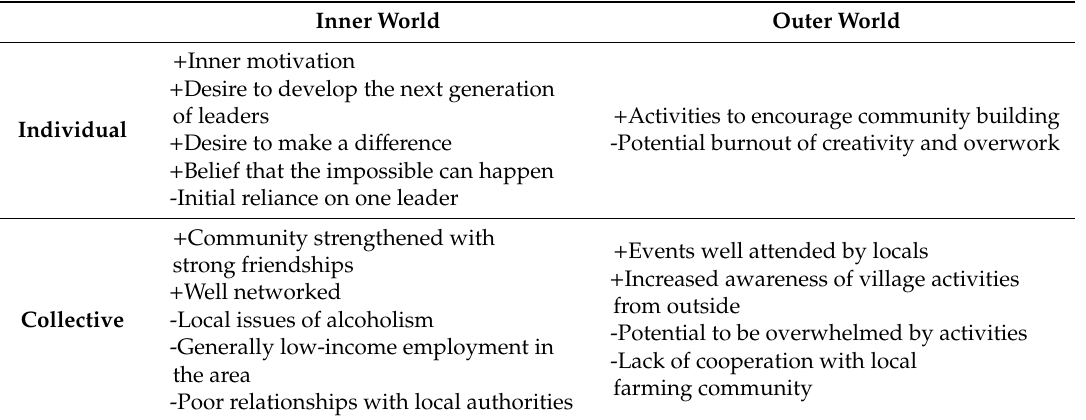
Table 6. Value-orientated leadership, Kaldabrun